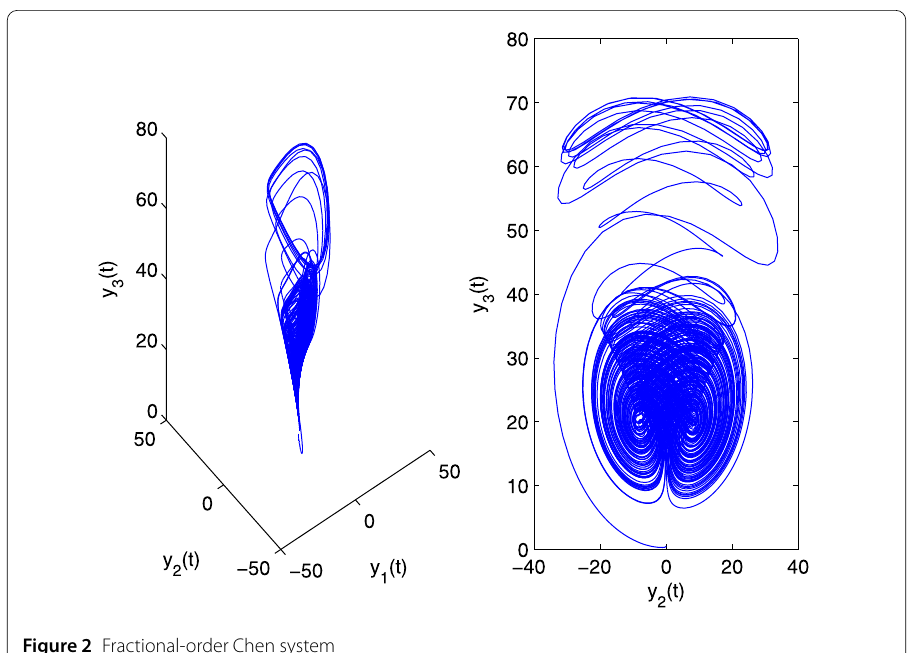
Figure 2 Fractional-order Chen